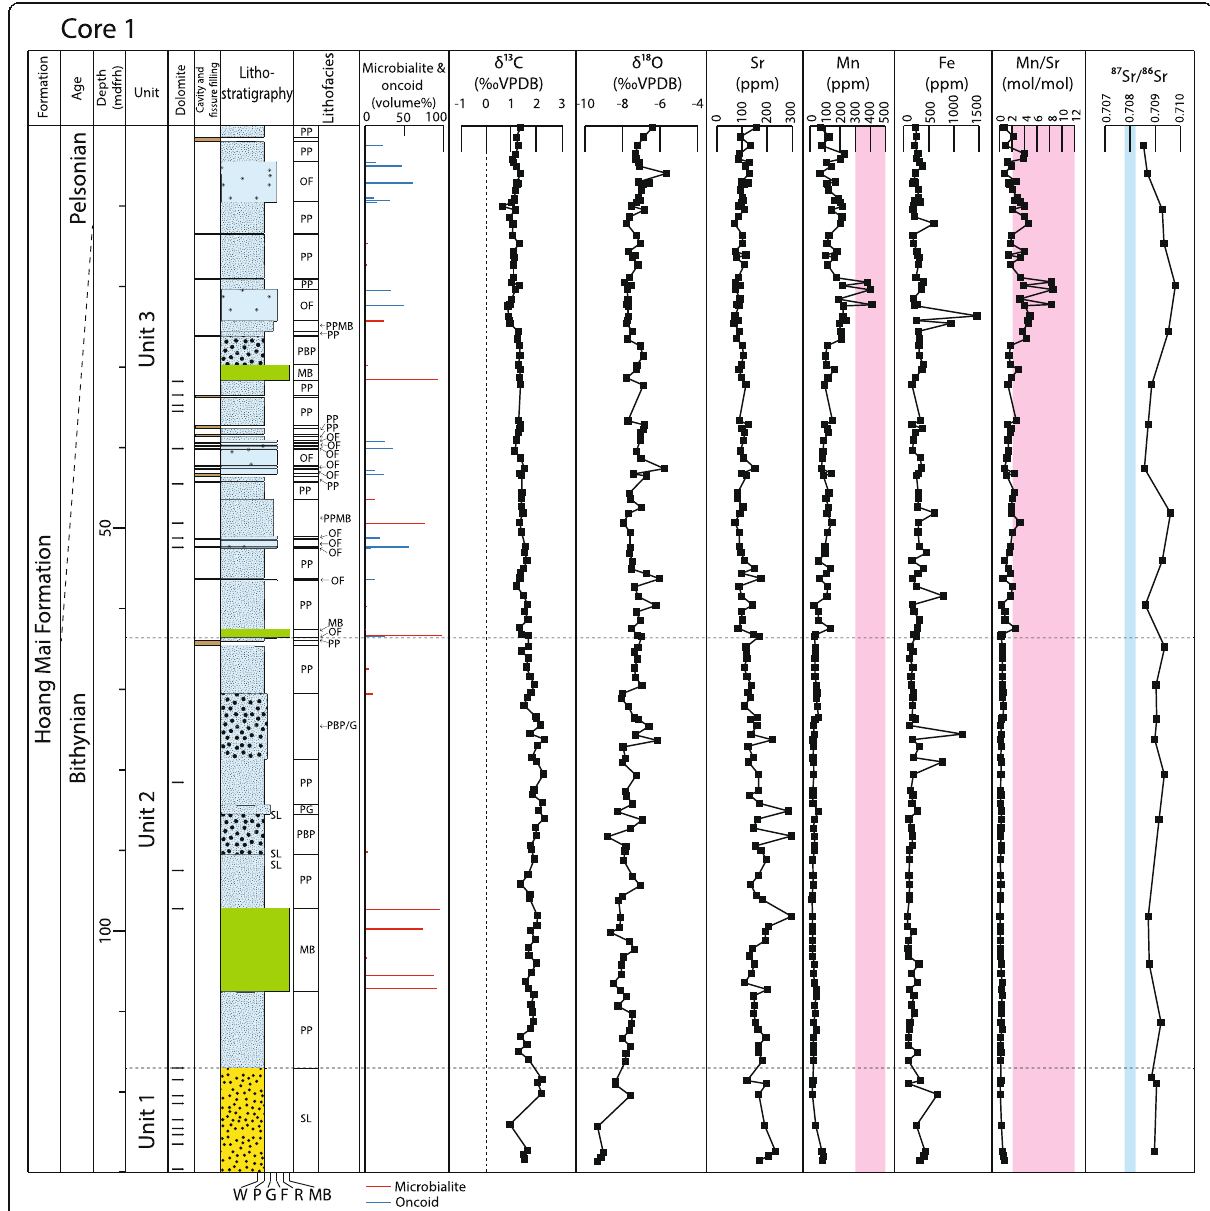
Fig. 2 Lithostratigraphy and chemostratigraphy of carbonates from core no. 1. Vertical profiles of δ 13 C and δ 18 O values, Sr, Mn, and Fe concentrations, and Mn/Sr and 87 Sr/ 86 Sr values of bulk carbonate samples from core no. 1. Note that the pink areas denote the threshold for samples determined to be diagenetically altered, based on criteria defined by Denison et al. (1994) and Jacobsen and Kaufman (1999). The blue area denotes 87 Sr/ 86 Sr of Anisian seawater (McArthur et al. 2001). BG, bioclastic grainstone; BP, bioclastic packstone; IG, intraclastic grainstone; MB, microbialite; NR, no recovery; OF, oncoidal floatstone; PBP, peloid bioclast packstone; PBP/G, peloid bioclast packstone/grainstone; PG, peloidal grainstone; PP, peloidal packstone; PP/G, peloidal packstone/grainstone; PPMB: peloidal packstone with/interlayers of microbialite; SL, sandy